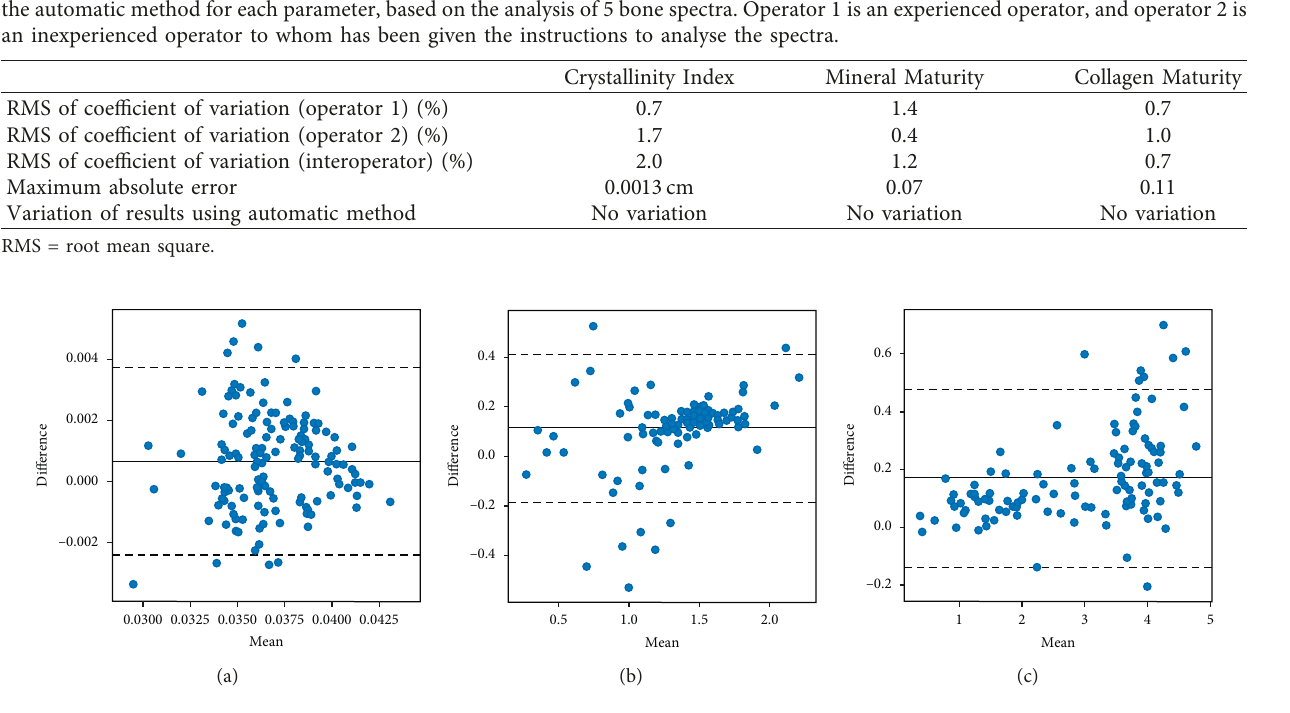
Variables used in the algorithm (Figure 10): OrigSpectrumData: raw MMA-embedded bone spectrum. RemSpectrumData: MMA-only spectrum.